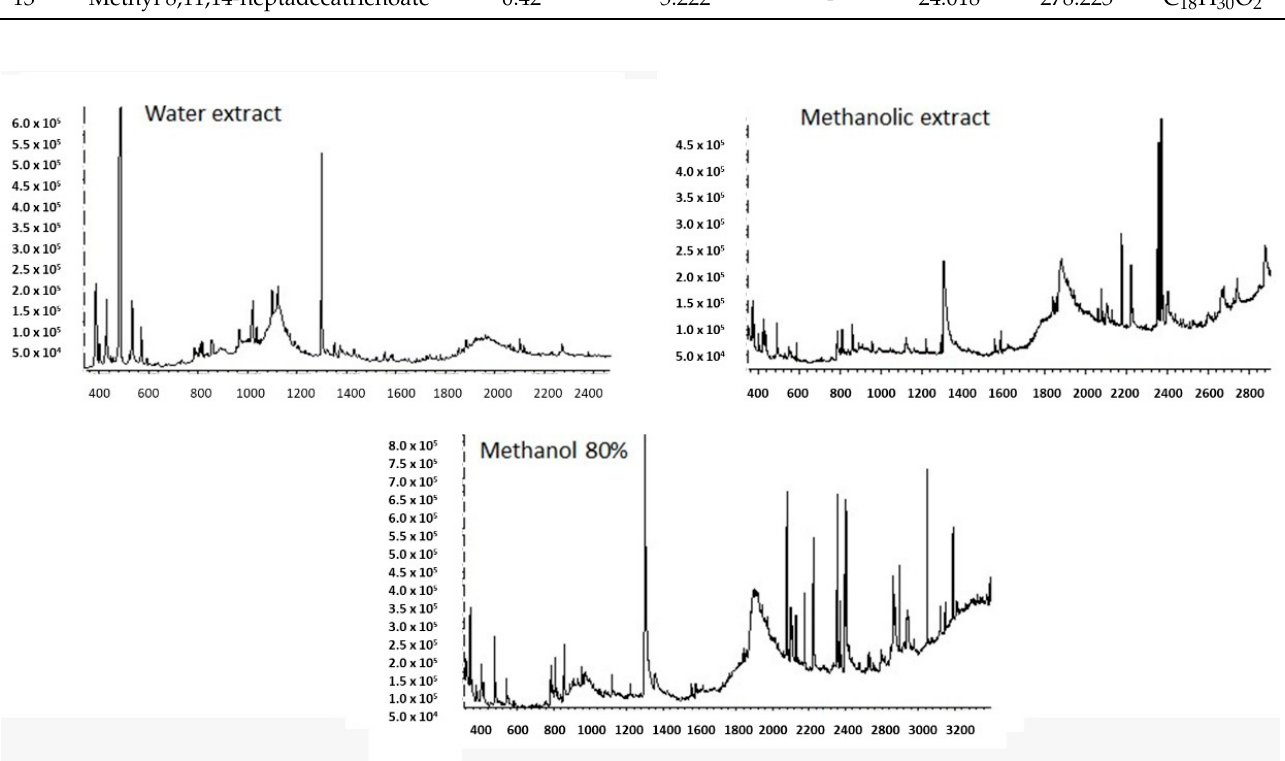
Figure 2. GC-MS chromatograms of aqueous, methanol and 80% methanol extracts of R. epapposum.